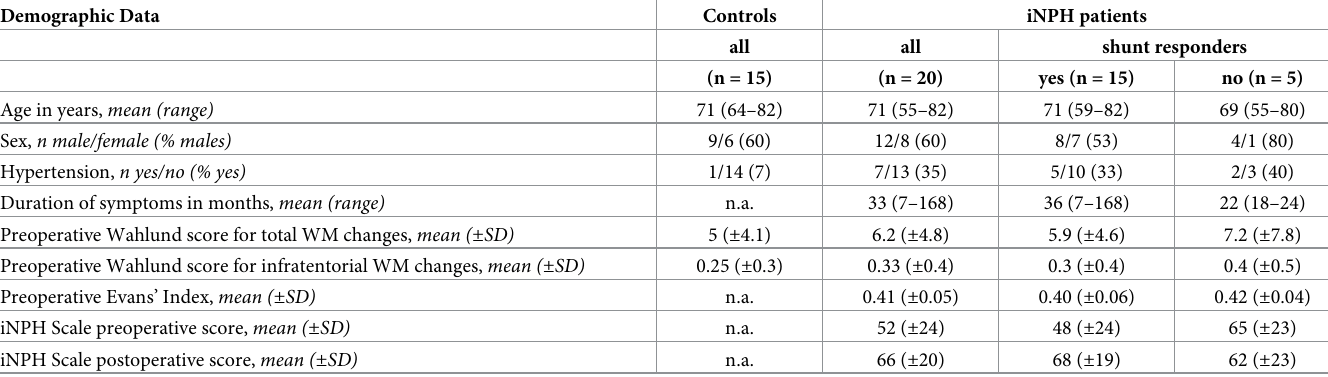
Table 1. Demographic data for controls and iNPH patients (shunt responders and